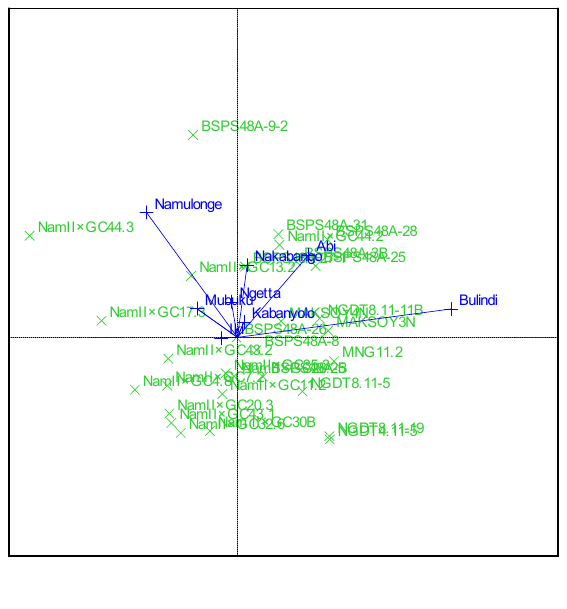
Figure 8. A GGE biplot showing the discriminating power and representativeness of the test environments involving 30 soybean genotypes evaluated in eight locations and six seasons.